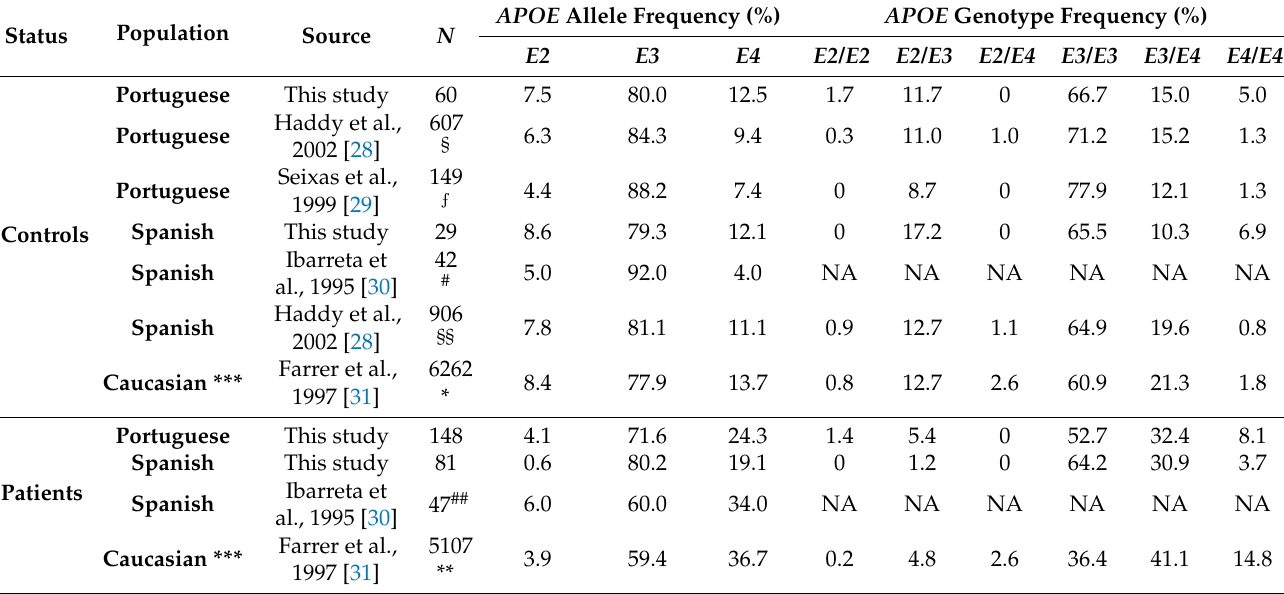
§ Individuals aged 25–64 years, free from serious and/or chronic illnesses (including AD) at the time of the recruitment, who attended different laboratories of the National Institute of Health of Lisbon. §§ Individuals aged 25–64 years, free from serious and/or chronic illnesses (including AD) at the time of the recruitment, from the area of Barcelona. ê Unrelated individuals born and living in Northern Portugal; information on age of individuals not available. # Individuals aged 52–90 years (mean ± SD, 67.7 ± 1.9) without any clinical symptom of AD from the area of Madrid. ## LOAD patients diagnosed in the Department of Neurology of the ‘Hospital Universitario Doce de Octubre’ (Madrid, Spain). * Controls aged between (mean ± SD) 37.2 ± 10.6 and 82.5 ± 8.4, free of neurodegenerative and neuropsychiatric illnesses. ** Patients diagnosed as having definite or probable AD excluding those with known mutations in the APP or presenilin genes or coexisting neuropathological findings (e.g., Lewy bodies, Parkinson disease changes). *** Subjects categorized as Caucasians by Farrer et al. [31], from the analysis of 37 different studies including AD patients and controls designated as: Caucasian (6264), Anglo-Saxon (667), French (704), French Canadian (792), Scandinavian (77), Finnish (259), Italian (280), Dutch (1848), German